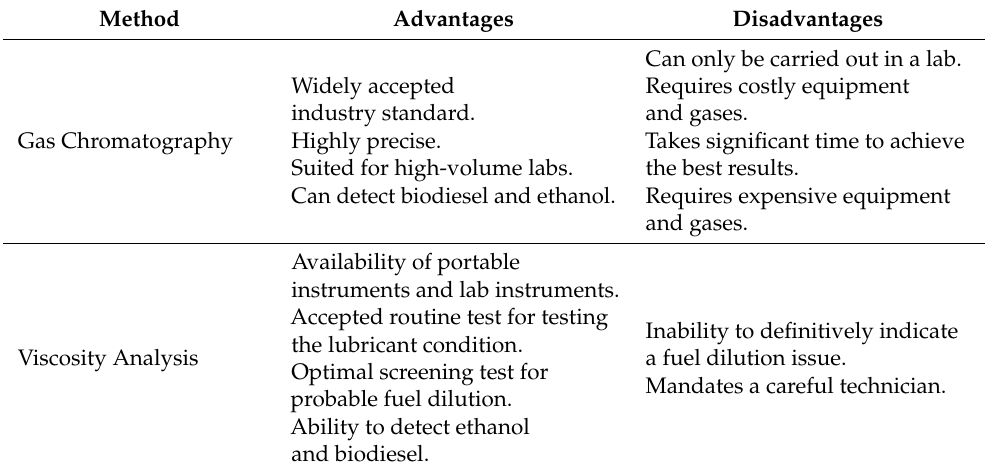
Table 2. Advantages and disadvantages of the main methods for detecting fuel in lubricating oil (prepared on the basis of Ref.